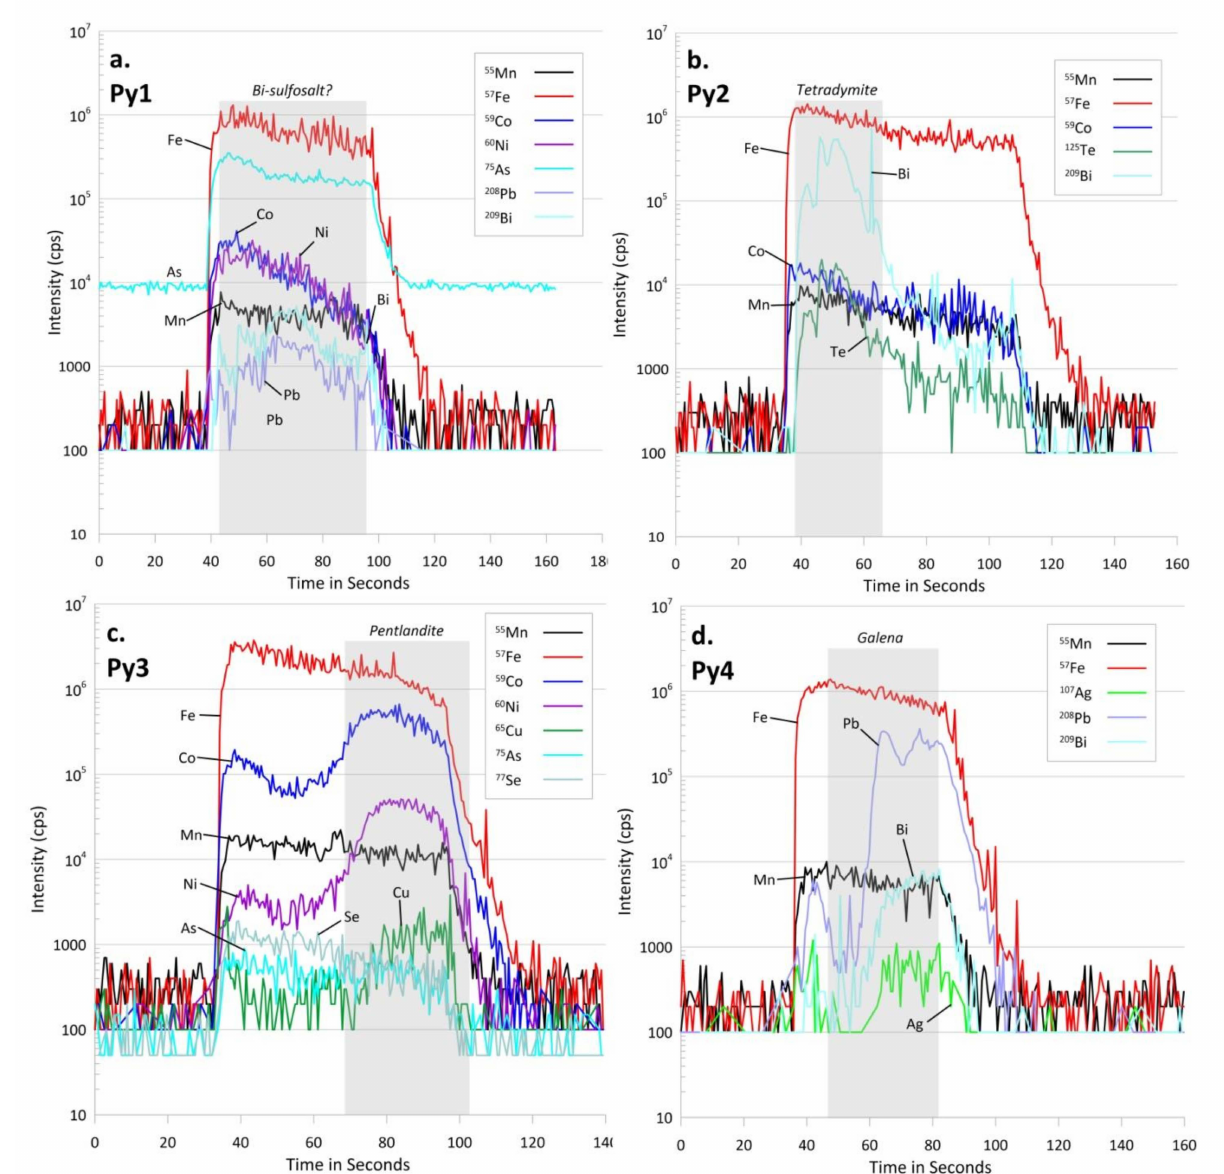
Figure 11. Selected time-resolved laser ablation ICP-MS depth profiles of pyrite ( a – d ) from the different groups and their associated inclusions (highlighted in gray). Manganese, Co, Ni, and As, where present, exhibit similar distribution patterns to Fe, unless stated otherwise: ( a ) in Py1, the distribution patterns of Bi and Pb could be related to nano-scale inclusions of Bi-sulfosalts; ( b ) in Py2, the spiky patterns for Bi and Te could suggest the presence of nano-scale inclusions of tetradymite; ( c ) in Py3, the similarly curved distribution patterns could be associated with the presence of pentlandite inclusions; ( d ) in Py4, the spiky patterns of Pb, Bi, and Ag could suggest the occurrence of galena